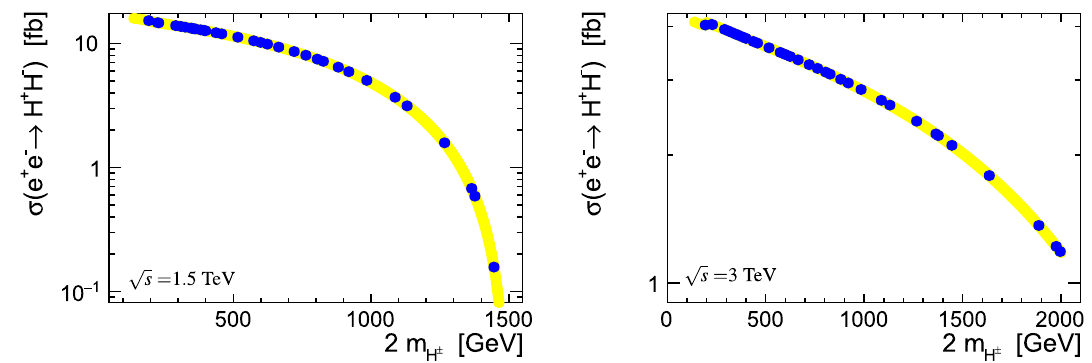
Fig. 1 Leading-order cross sections for the charged inert scalar production, e + e − (right). The yellow band represents all scenarios selected in the model scan [26] while the blue dots represent the selected benchmark scenarios. Beam energy spectra are not included. Figure taken from